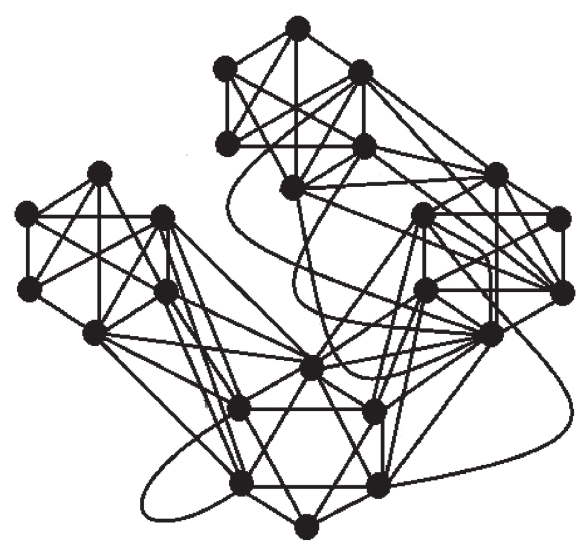
Figure 4: Graph of L ( CS ( 4 ))